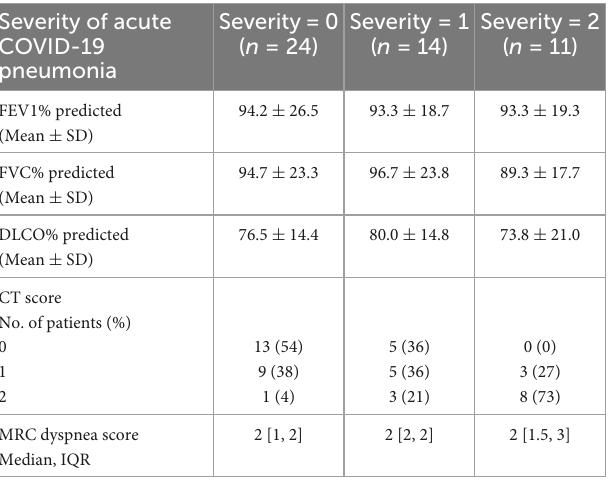
TABLE 2 Severity scores of acute coronavirus disease-2019 (COVID-19) pneumonia and details of follow-up thoracic computed tomography (CT) and lung function tests in the post-COVID